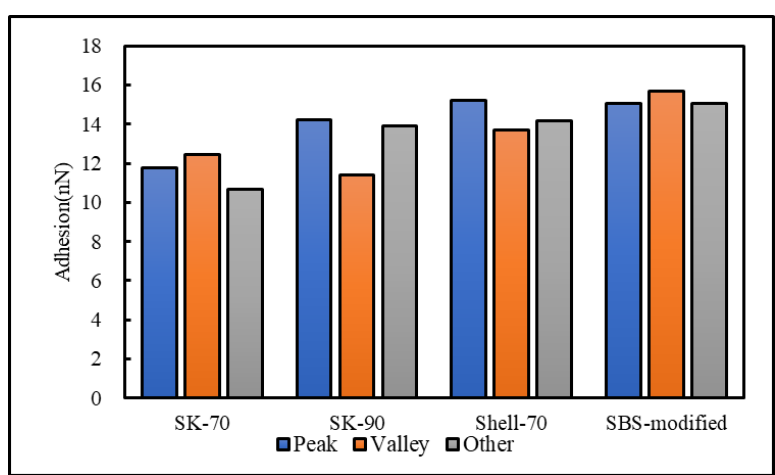
Figure 17. Adhesion between the probe and soaked asphalts in di ff erent regions.